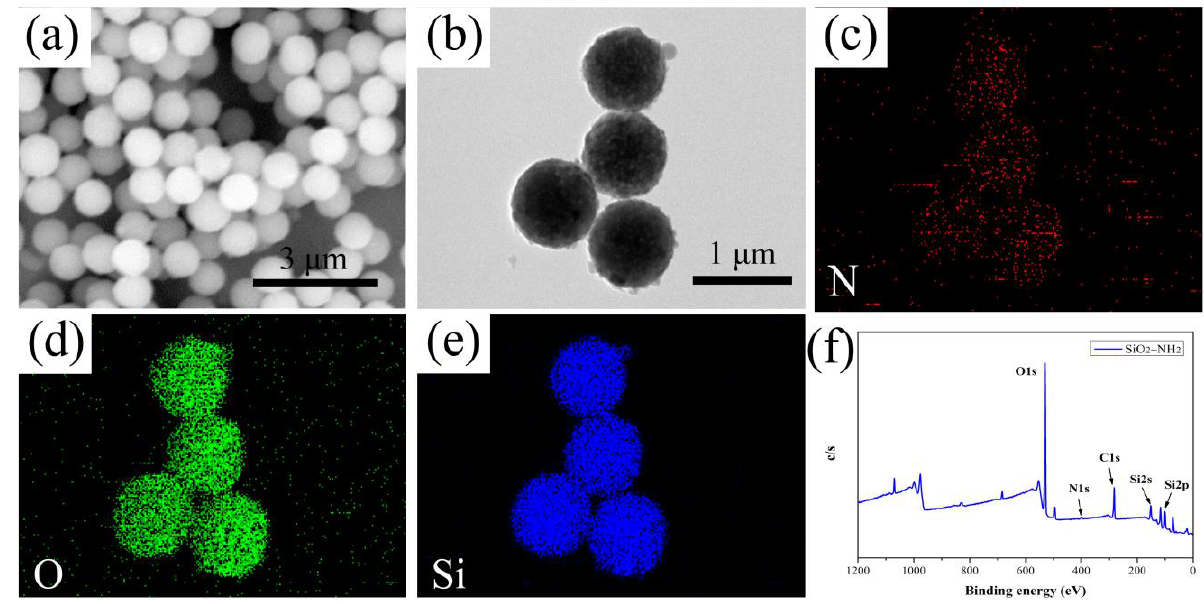
Figure 2. ( a ) SEM, ( b – e ) TEM-EDS mapping and ( f ) XPS images of SiO 2 – NH 2 .